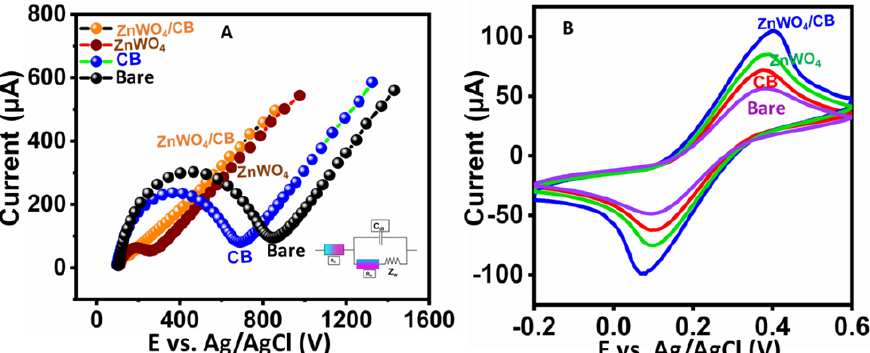
Figure 5. ( A ) EIS; and ( B ) CV studies of bare GCE, CB/GCE, ZnWO 4 /GCE, and GCE/ZnWO 4